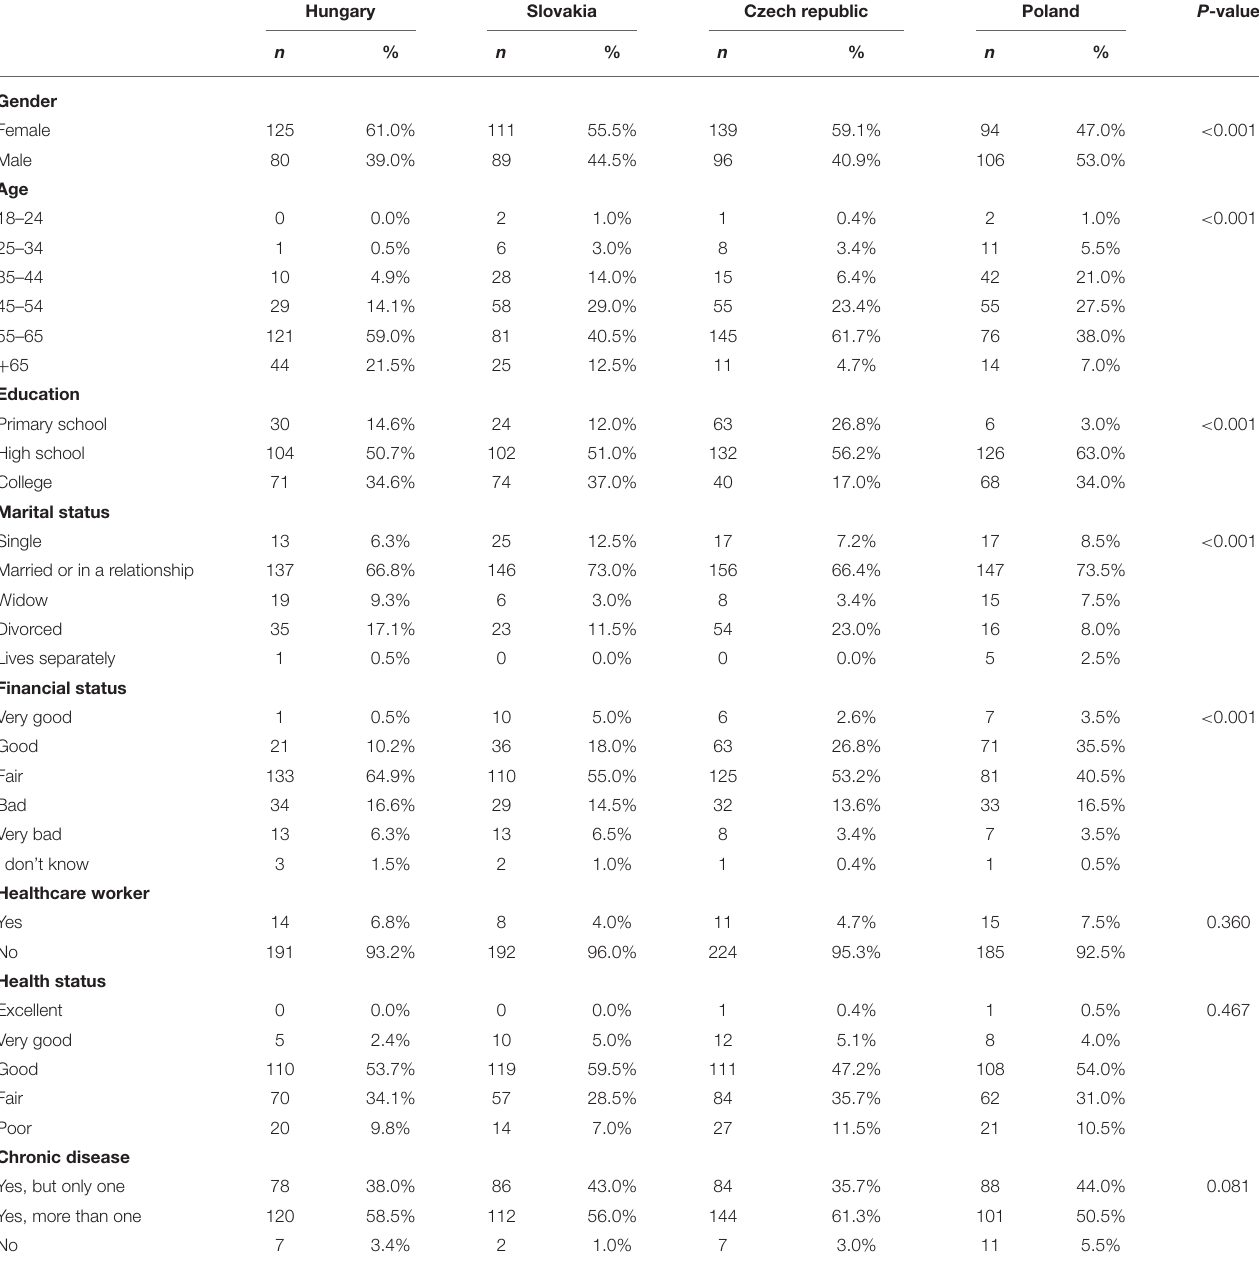
TABLE 1 | Demographic data of the respondents in the Visegrad Group